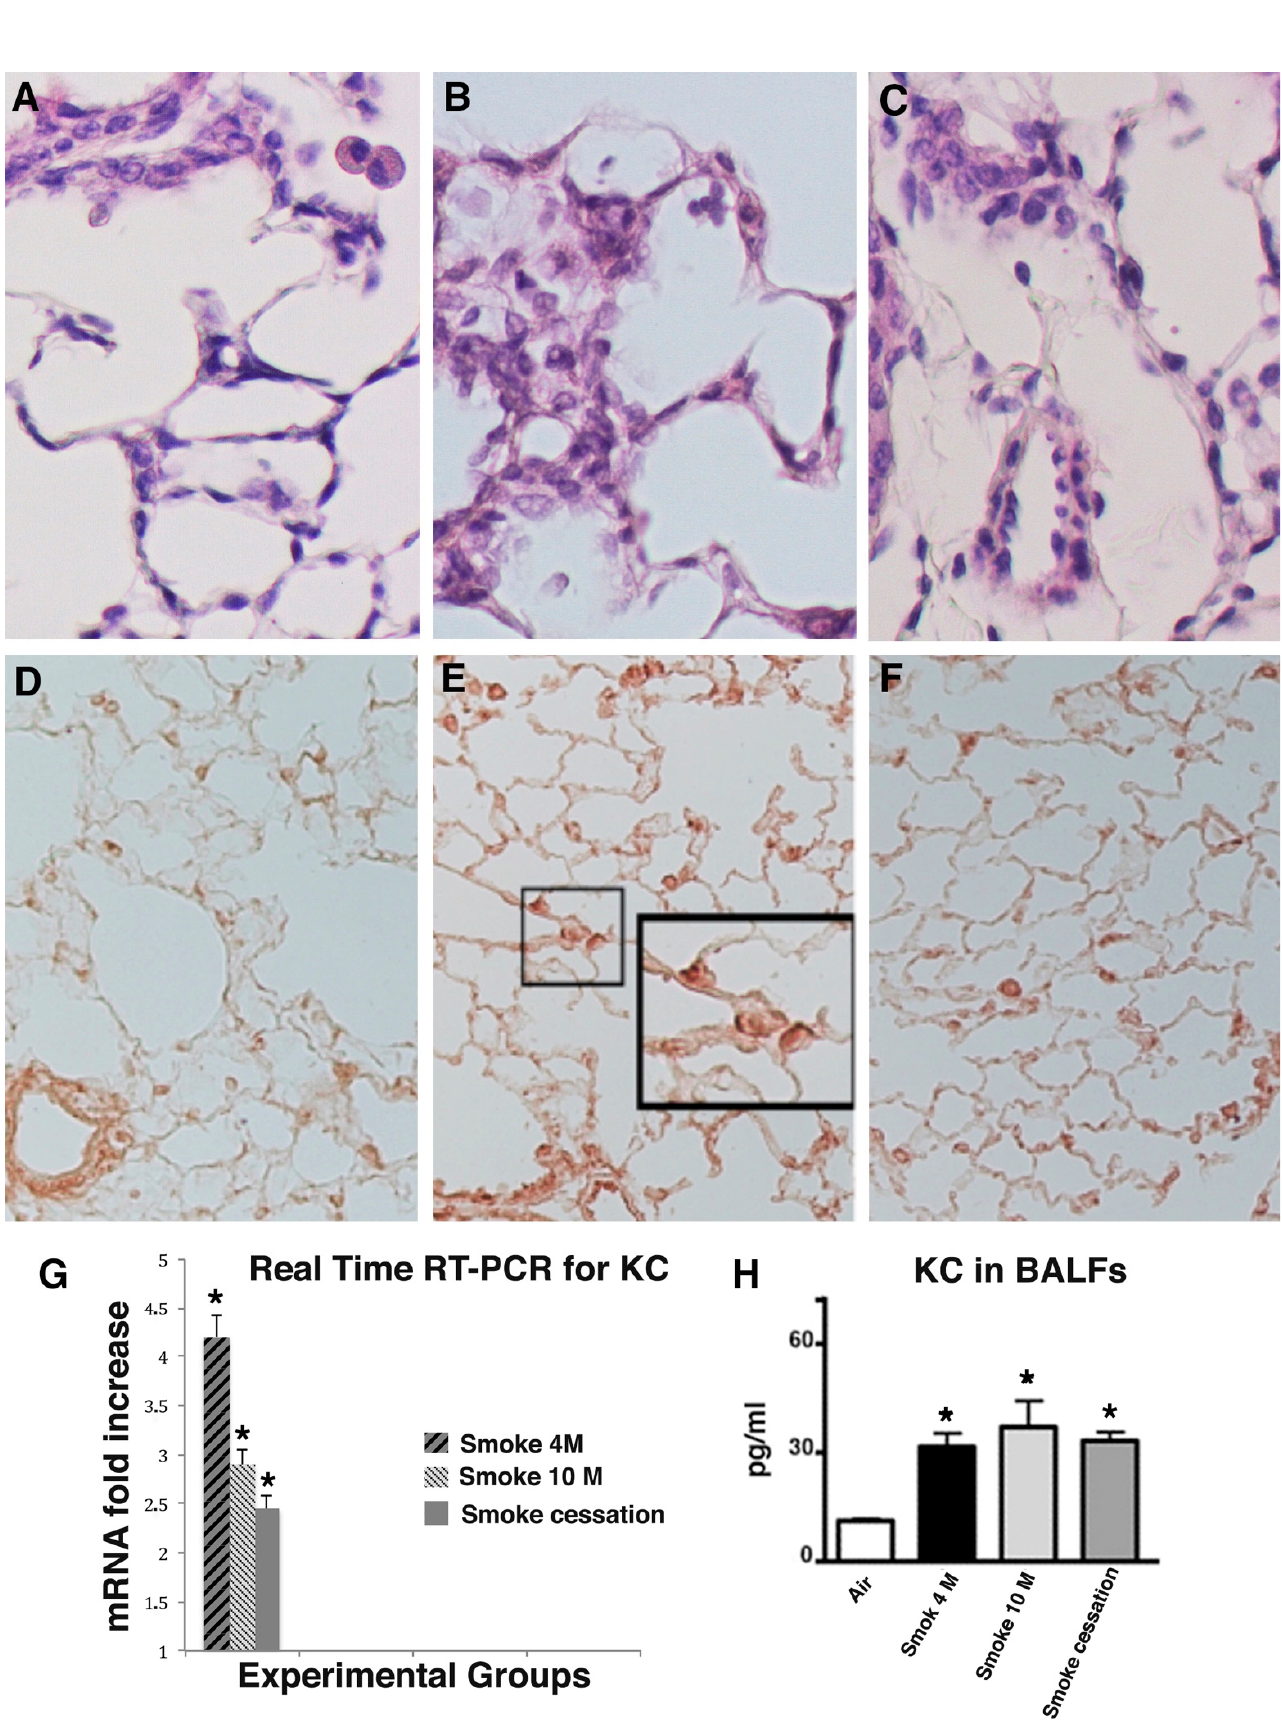
Figure 2. Neutrophilic inflammation and KC expression in lungs of smoking mice: ( A ) Lung from